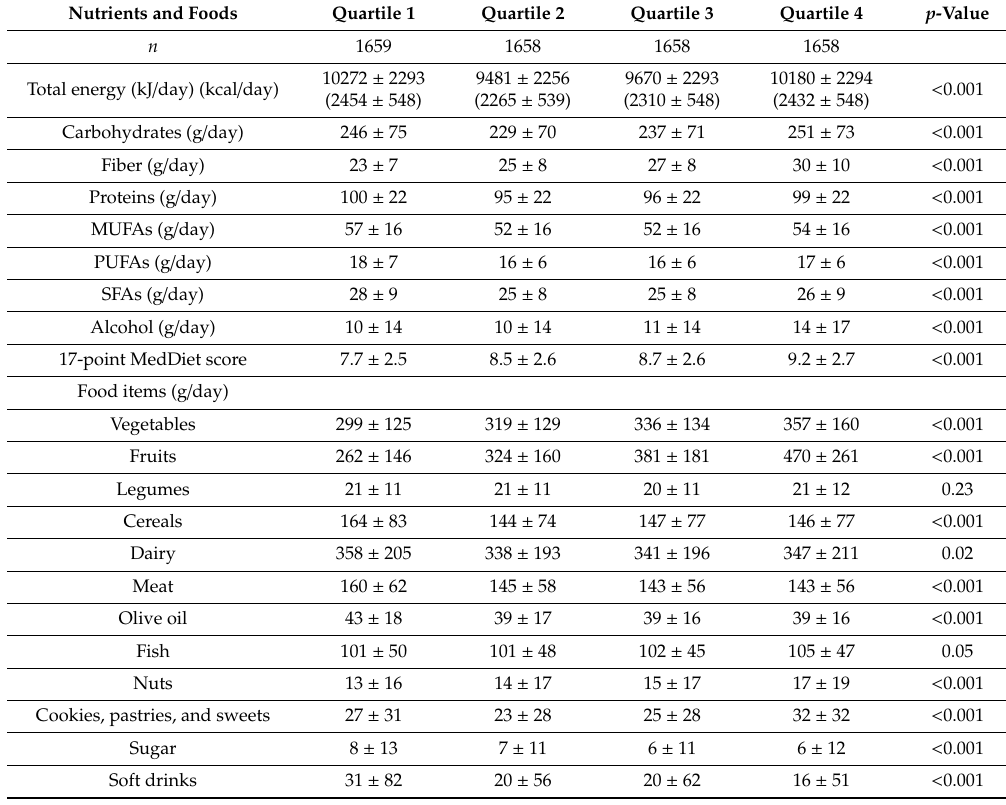
Table 2. Main dietary nutrient and food consumption according to quartiles of energy-adjusted polyphenol intake at baseline ( n =